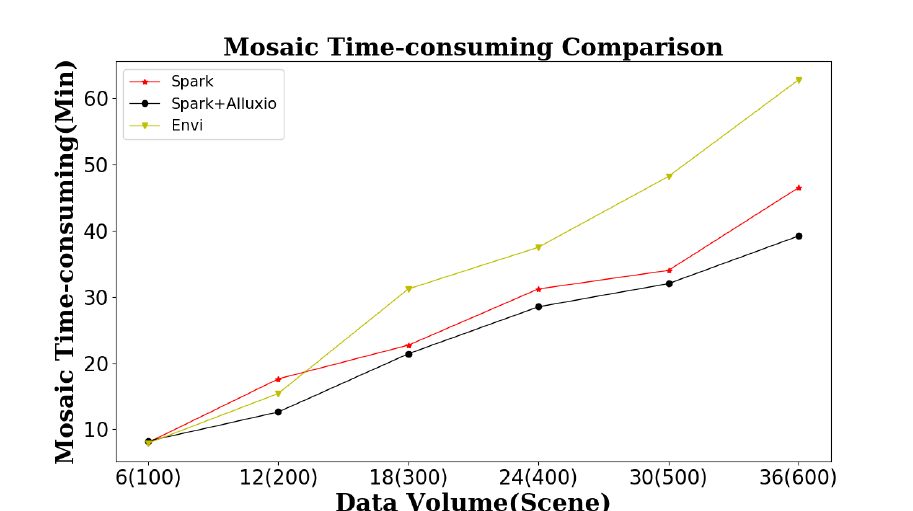
Figure 8. Comparison of ENVI and Spark and Spark with Alluxio for remote sensing image mosaic